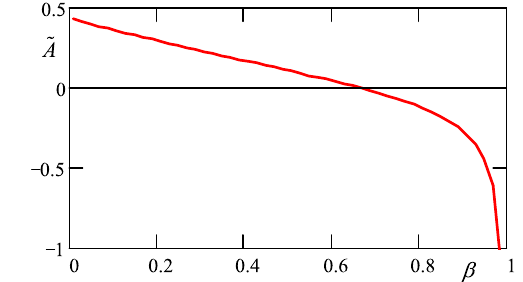
FIG. 4. The normalized work performed by the field ~ A ¼ q − 2 aA , depending on the velocity of the